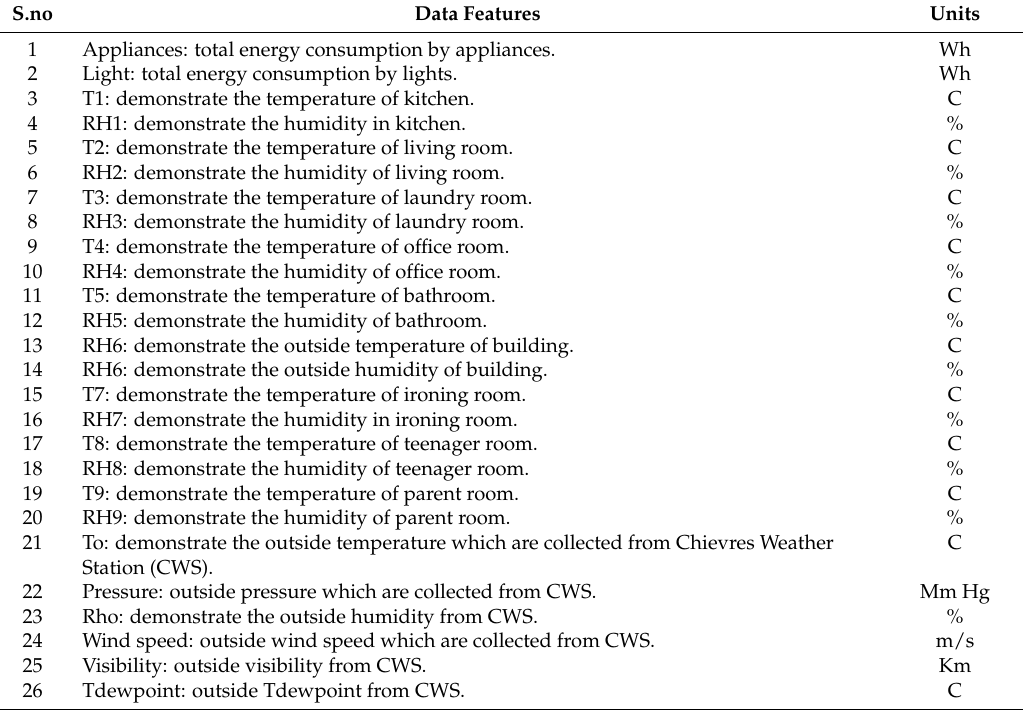
Table 1. AEP dataset variables, a short description and its